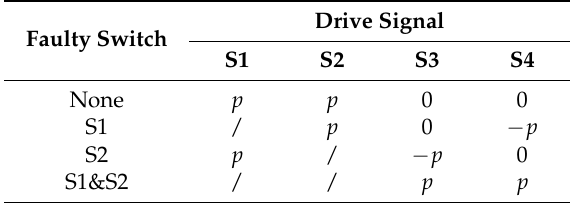
Table 1. Drive signal distribution of different fault switch.